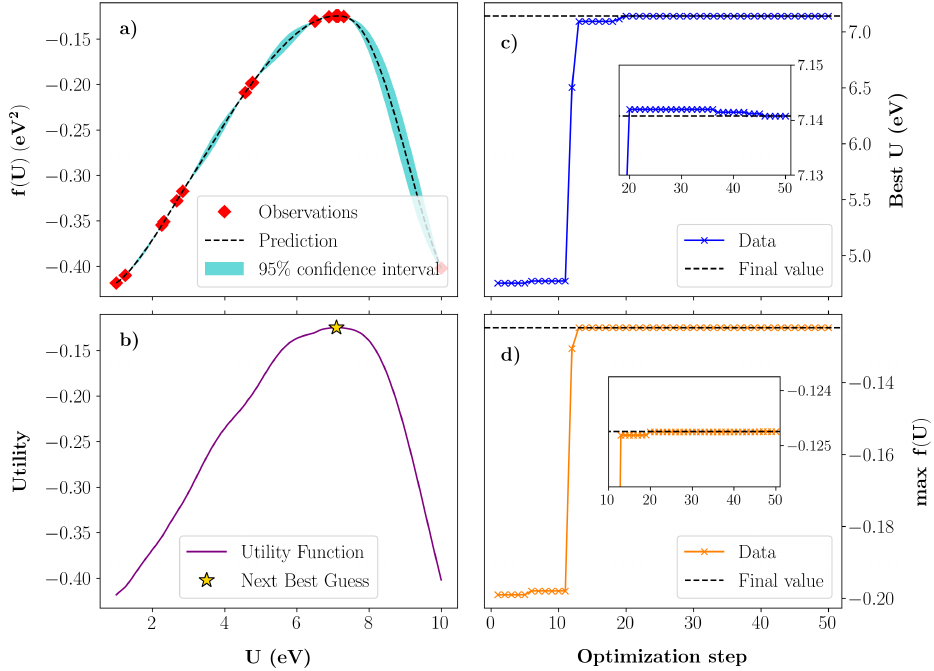
Figure 3. Performance of Bayesian optimization of Hubbard U in InN: ( a ) approximate objective function, observations, and 95% confidence interval after 50 optimization steps; ( b ) Utility (acqui- sition) function after 50 steps, with the next point to be evaluated as suggested by the algorithm; ( c ) Evolution of the predicted best value of U, the inset shows the Us within ± 0.01 eV about the final value; ( d ) Best approximation of the maximum of the objective function as a function of the optimization step, the inset shows maxima of f within ± 0.001 window around the final